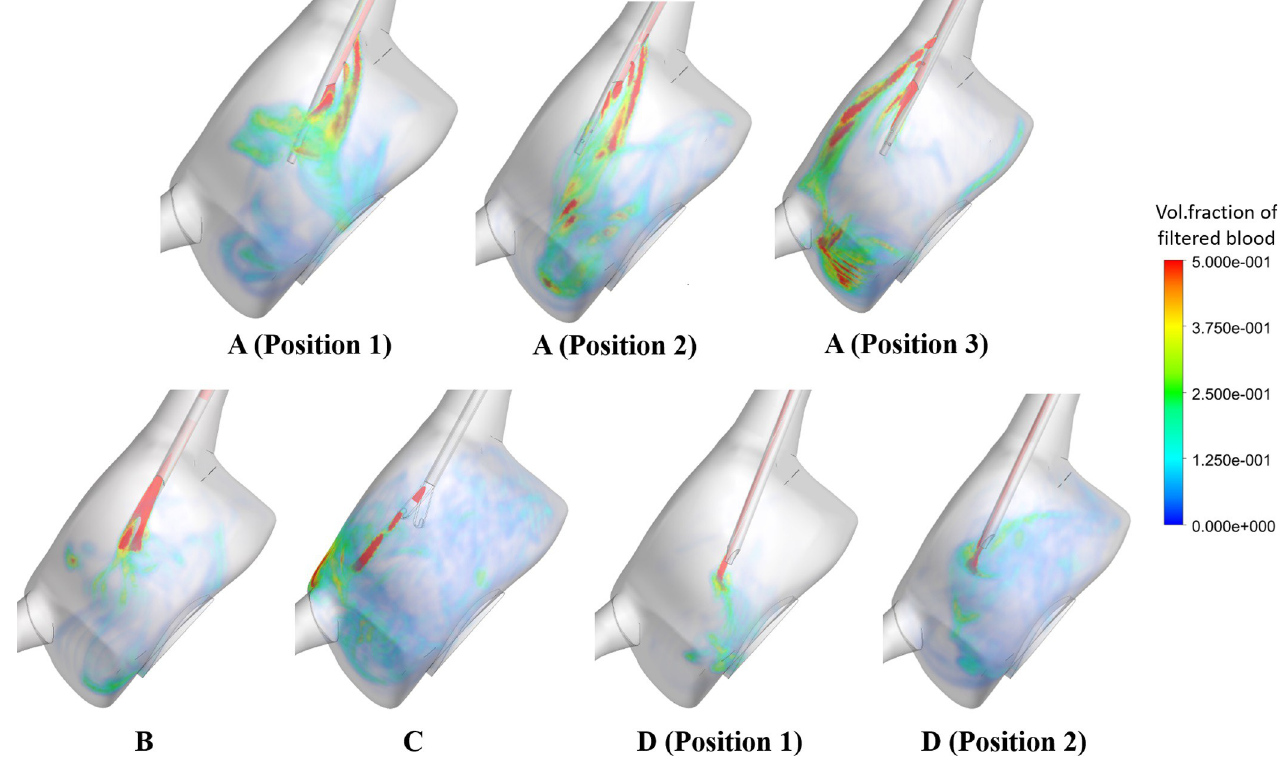
Fig 15. Time-averaged volume fraction of filtered blood (recirculation phase) within the RA for all catheter models.